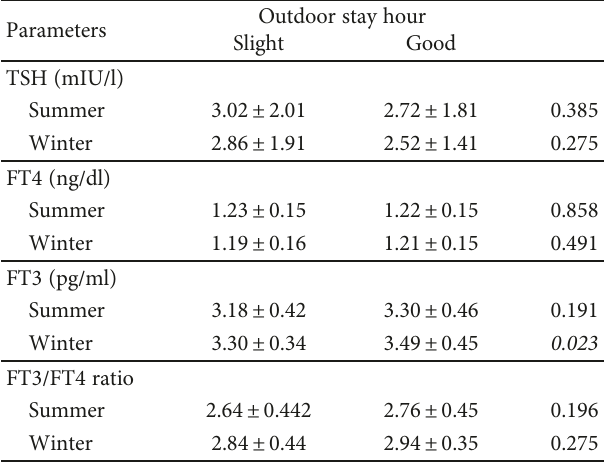
Table 4: Comparison of the serum TSH, FT4, and FT3 between degrees of exposure to environmental temperature in summer and winter